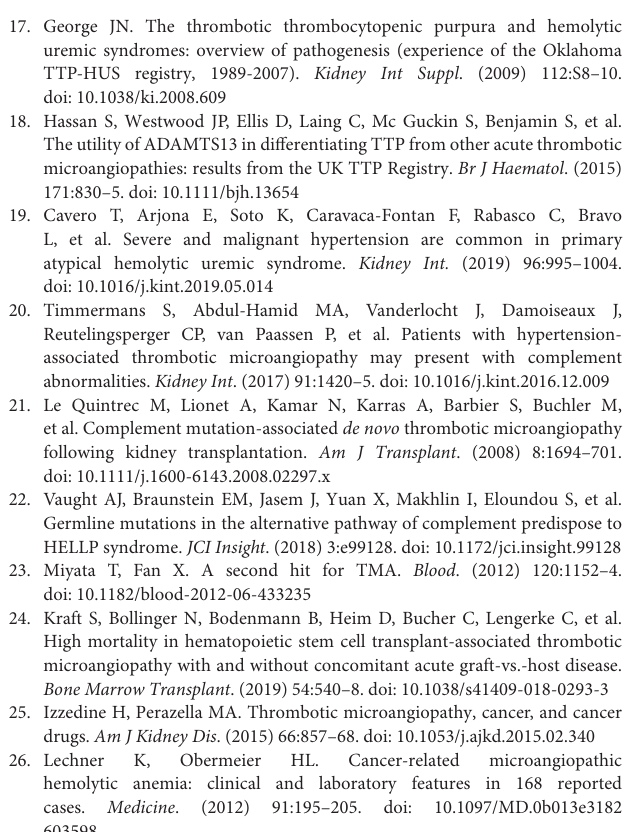
Supplementary Figure 1 | Site of initial hospital admission. Supplementary Figure 2 | Number of patients according to TMA etiology. Supplementary Table 1 | Diagnosis criteria for classifying the causes of TMA. Supplementary Table 2 | Patients with full TMA biological syndrome without TMA. Supplementary Table 3 | Characteristics of patients with “other” TMA causes. Supplementary Table 4 | ADAMTS13, complement and autoimmune